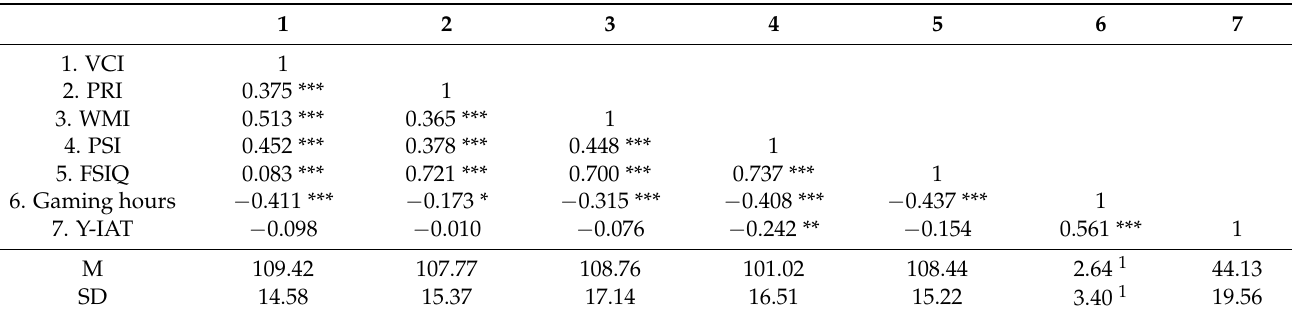
Table 5. Correlations of variables in total sample ( n =